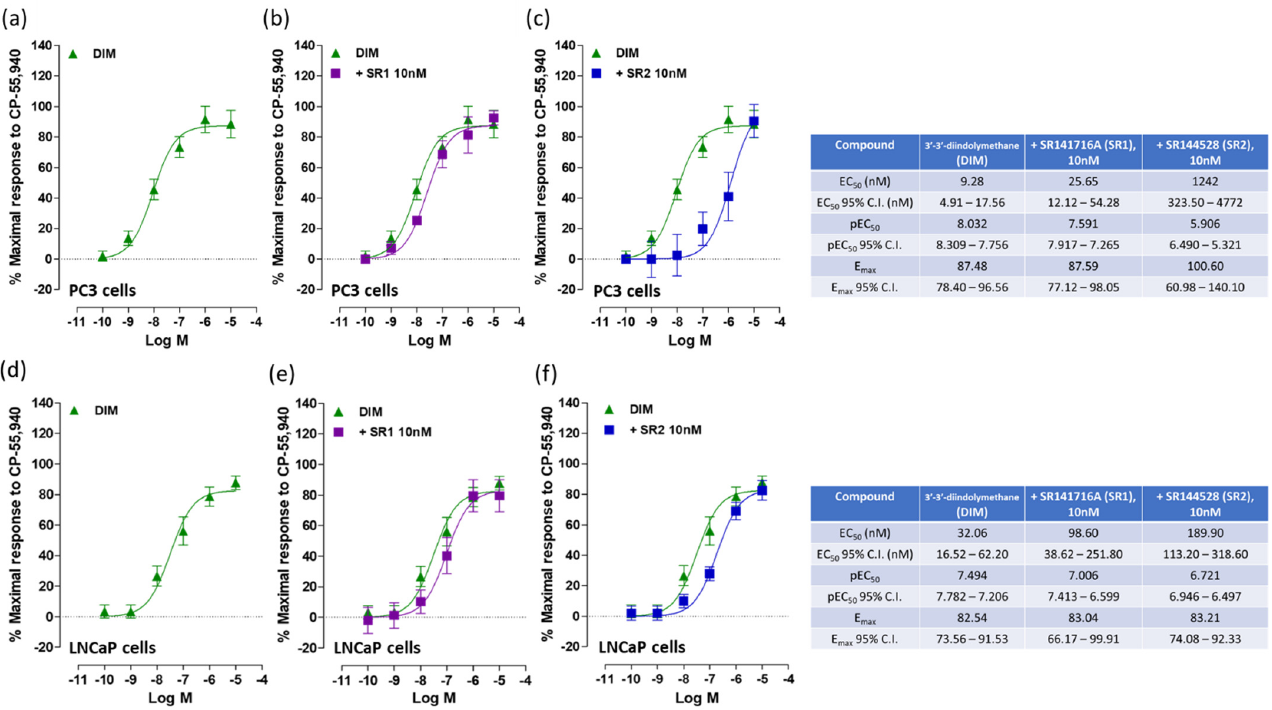
Figure 2. Effects of DIM and CP 55,940 on [ 35 S]GTP γ S in LNCaP cell membranes. The effects of DIM and CP 55,940 ( a , d respectively) were also tested in the presence of CB 1 receptor antagonist SR1 ( b , e ) and CB 2 receptor antagonist SR2 ( c , f ). Each data point is the mean percentage value ± S.E.M. ( n = 15). EC 50 , E max , pEC 50 and 95% confidence intervals are shown in the table.